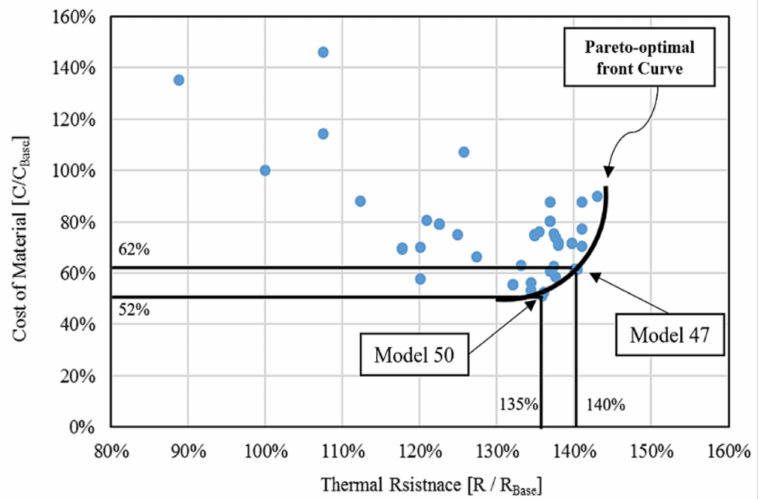
Figure 14. Pareto-optimal front plot in the objective